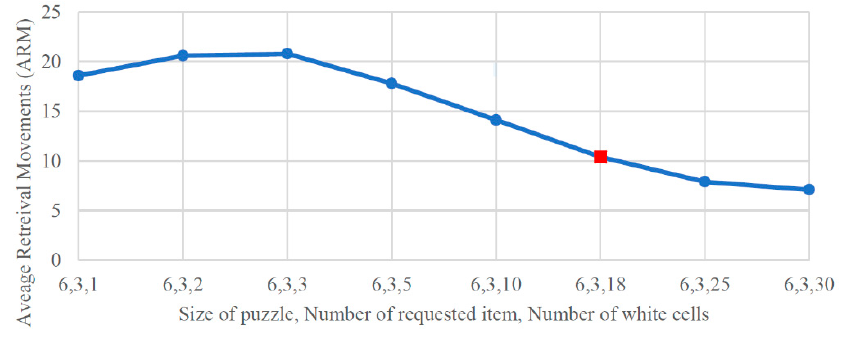
Figure 15. The effect of the number of white cells on the ARM in a 6 × 6 puzzle.